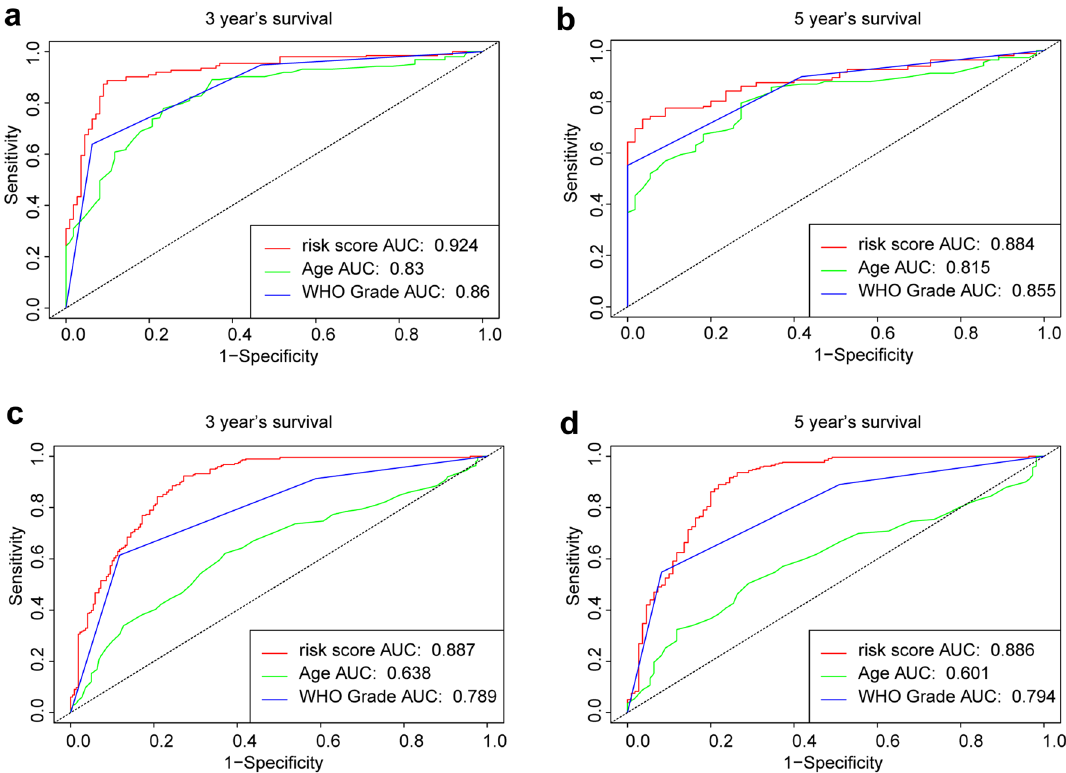
Figure 3. Comparisons of survival predictive efficiencies between the risk score and clinicopathological characteristics. ROC curves showed the predictive efficiencies of risk scores, age and WHO grade on 3-year and 5-year survival rates in the TCGA ( a , b ) and CGGA ( c , d ) data